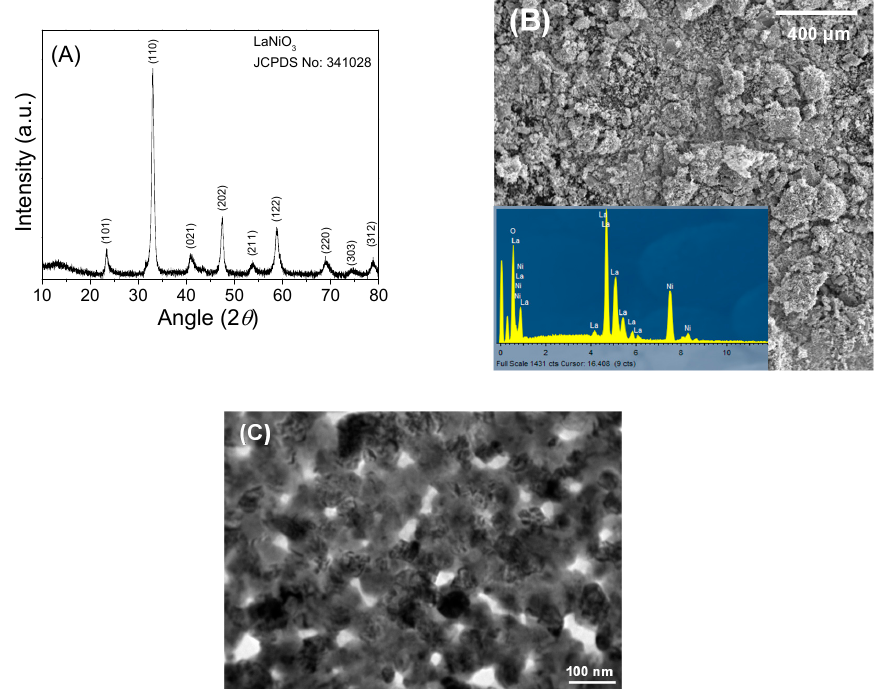
Figure 1. ( A ) X-ray di ff raction pattern, ( B ) SEM image with energy dispersive spectrometer (EDS) spectrum and ( C ) TEM image of LaNiO 3